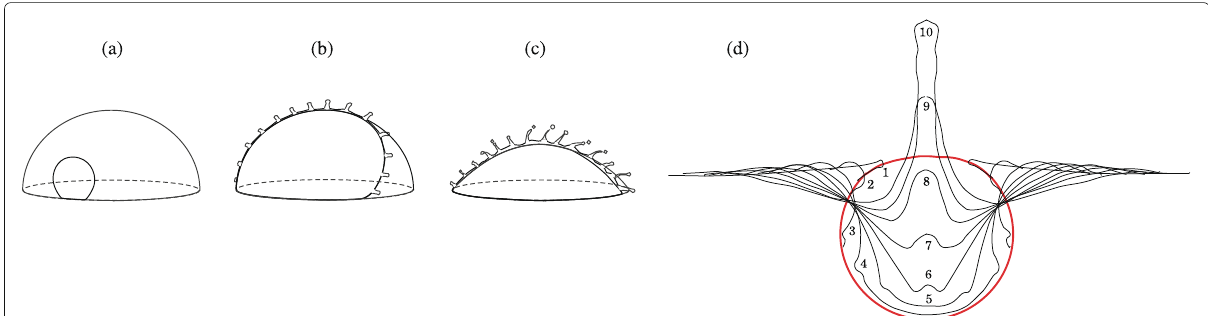
Fig. 14 a , b and c : schematic representation of bursting of an air bubble in succession (modified after Lhuissier and Villermaux 2012, figure 18). Only the film cap of the bubble is shown. a A pin-hole rupture in the film expands. b The rolled-up film starts to disintegrate into pieces of strings by Rayleigh-Taylor instability. c The instability continues to break up strings into multiple droplets, which is detached and ejected in tangential direction from the original film curvature, called film droplets. d : schematic representation of jet-droplet formation (modified after MacIntyre 1972, figure 1). The succession of profiles are ∼ 1/6000 s apart, from label 1 through 10. The pseudo-circle in red indicates a shape of bubble just before the film rupturing. The profile 1 represents the moment the film cap is stowed away into its base perimeter by surface tension. The perimeter (now the edge of the gaping cavity) starts to collapse due to a continuous action of surface tension, generating a capillary wave that travels along the cavity wall to the bottom (profiles 2 through 5). The wave converges in the center to form an upward-moving jet (profiles 6 through 9). The jet starts to deform into nodes (profile 10) due to Savart-Plateau-Rayleigh instability (Duchemin et al.